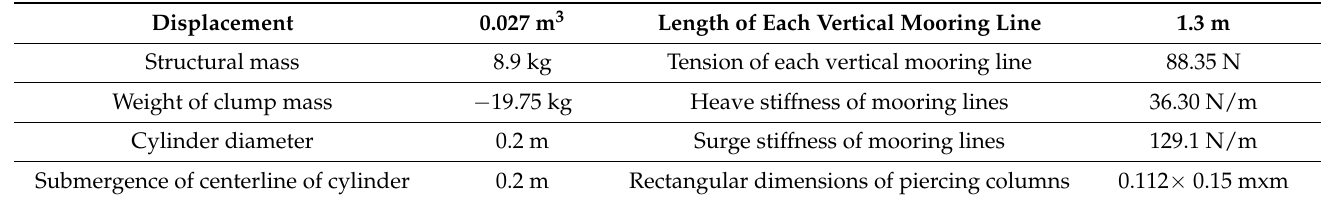
Figure 5. Developed numerical models used for the examined WEC: ( a ) potential theory (PTM) numerical model (Equations (1)–(5)), ( b ) panel discretization of the wet surface of the PTM model, (1)–(5)), ( b ) panel discretization of the wet surface of the PTM model, ( c ) CFDM for decay curves calculation (Equations ( c ) CFDM for decay curves calculation (Equations (6)–(7)) and ( d ) 3D model of the WEC (Equation (6)–(7)) and ( d ) 3D model of the WEC (Equation (8)). (8)). Table 1. Design characteristics of the examined wave energy converters